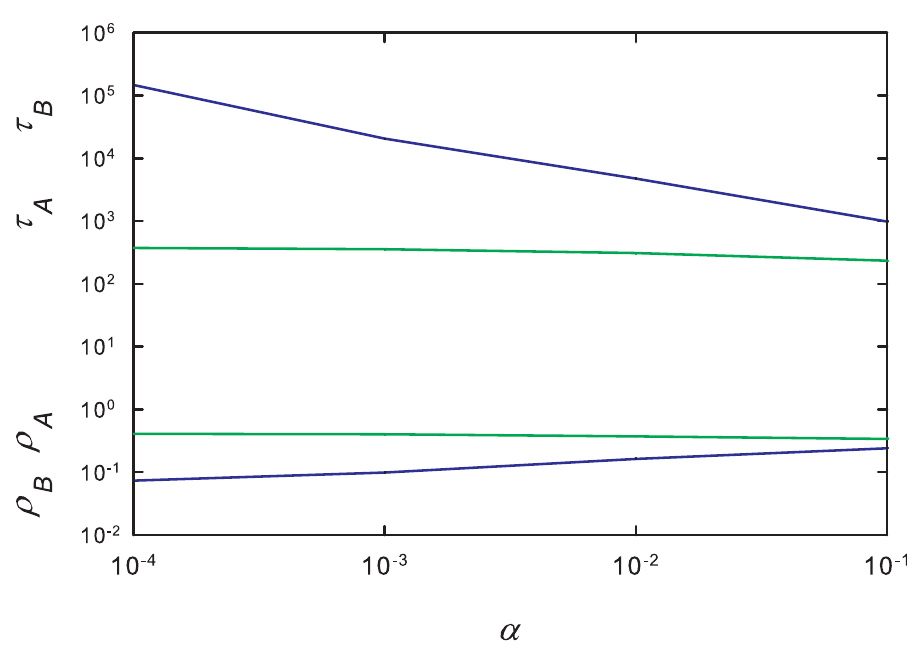
Fig 12. (Color online) Quasistationary population densities (lower) and lifetimes (upper) for fast (green lines) and slow (blue lines) species versus α on a ring of 14 sites, for λ = λ c = 3.29785.